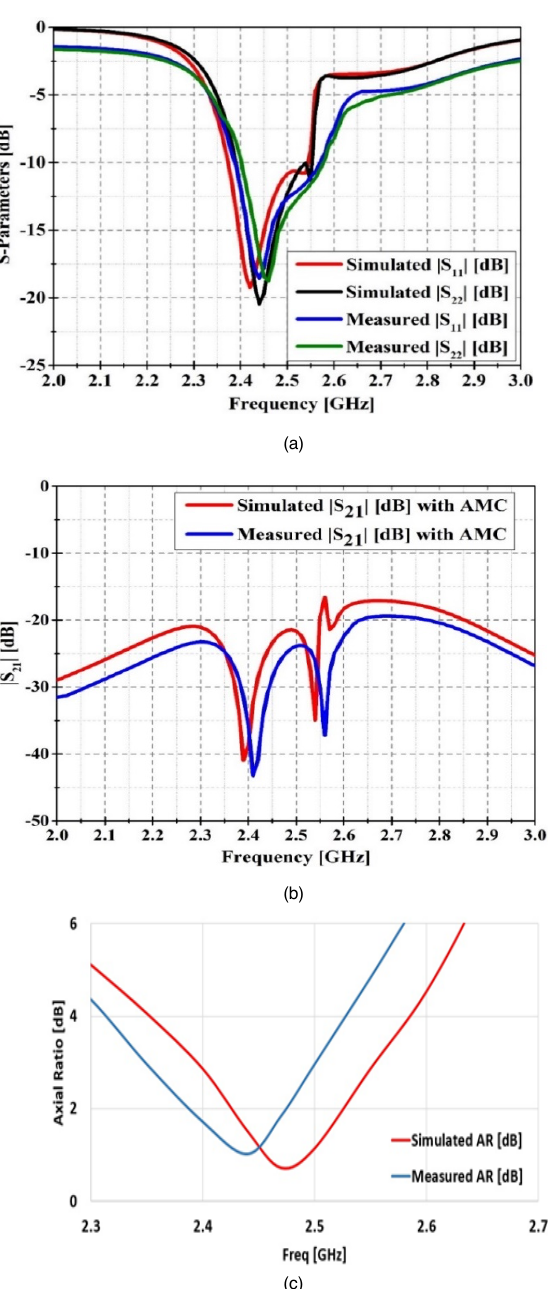
FIGURE 9 . Simulated vs. Measured Results (a) S 11 and S 22 (b) S 21 and (c) Axial Ratio (AR)